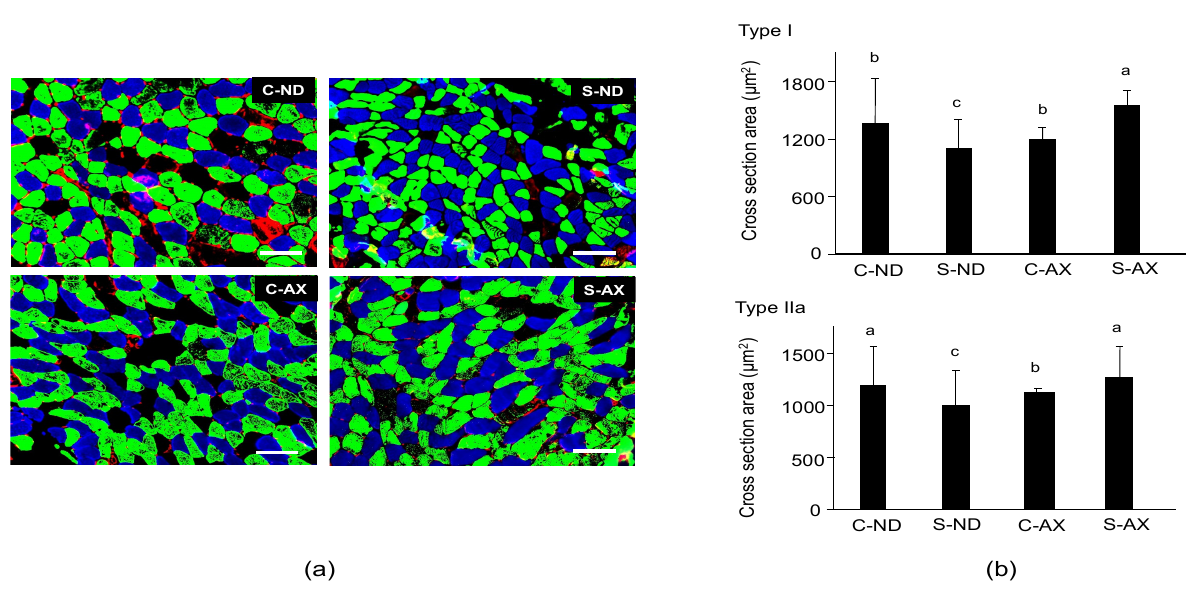
Figure 3. Effect of dietary AX on cross-sectional area (CSA) and fiber size in the soleus (SO) muscle of tail-suspension mice. ( a ) Sections (5 µ m thickness) of SO muscle from C-ND, C-AX, S-ND, and S-AX groups, with multicolor immunofluorescence staining. Scale bar = 100 µ m. Magnification, × 20; ( b ) The average CSA of type I and type IIa fibers in the soleus muscle. Data are presented as mean ± S.D. ( n = 3). Different letters indicate significant differences ( p < 0.05) based on the one-way ANOVA and Tukey’s test. C-ND, control mice fed the normal diet; S-ND, tail-suspension mice fed the normal diet; C-AX, control mice fed the AX-supplemented diet; and S-AX, tail-suspension mice fed the AX-supplemented diet.